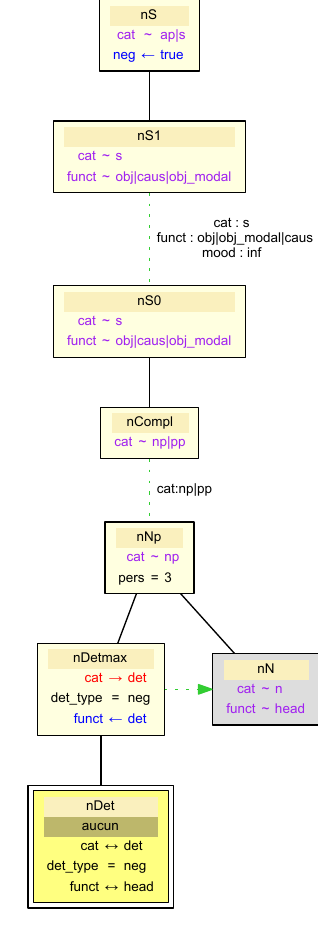
Figure 17: EPTD attached at the clitic ne and an EPTD attached at the negative satellite aucun